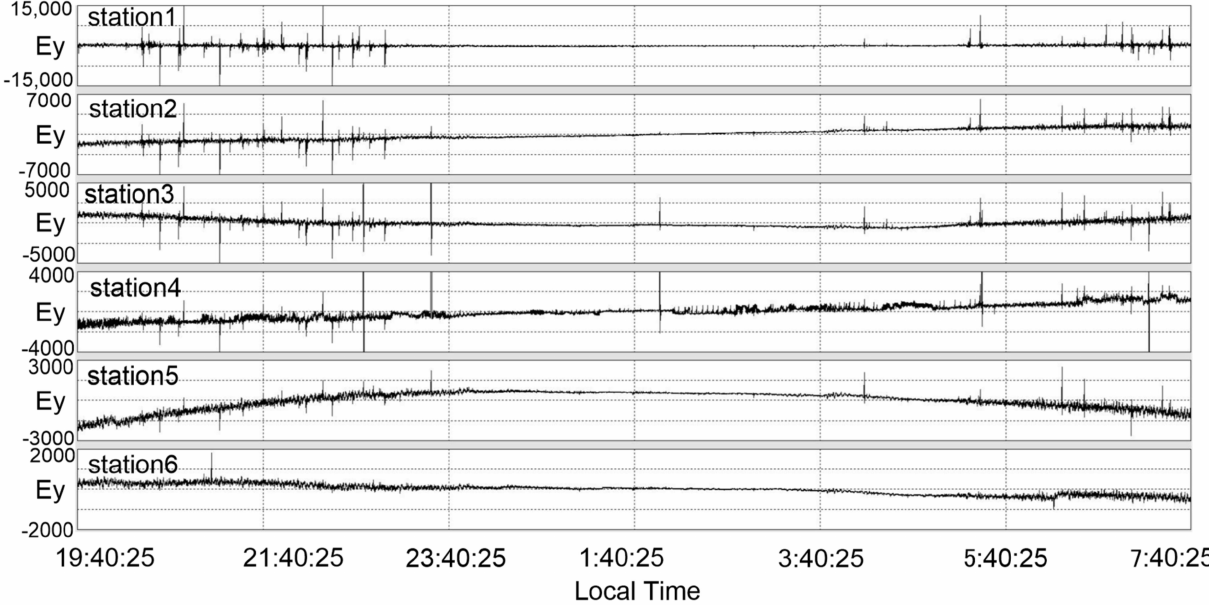
Figure 4. The 12 h time series of Ey recorded at stations